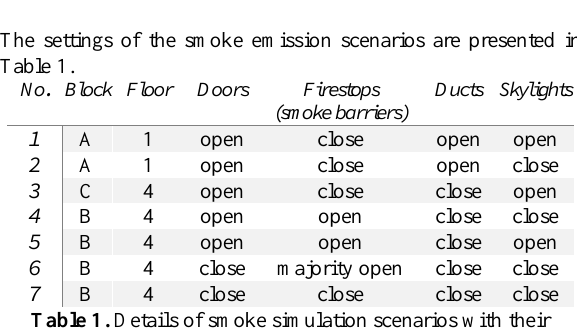
Figure 5. The 3D model at LOD4 in FDS.